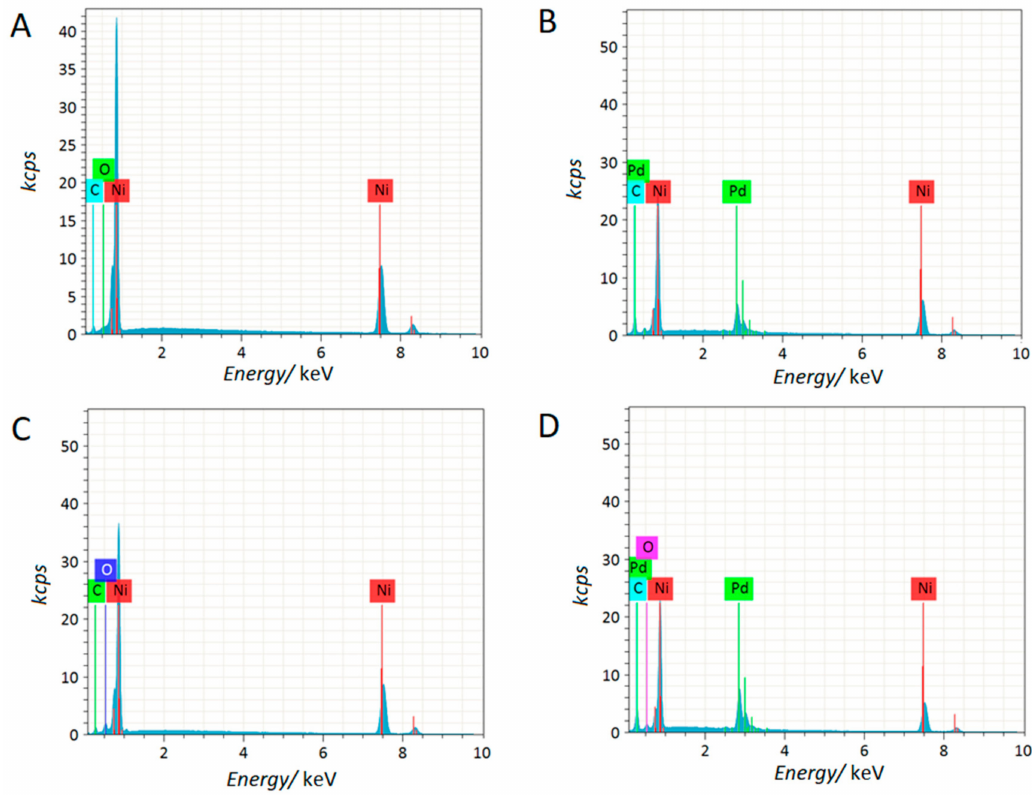
Figure 1. ( A ) EDX spectrum carried out at an acceleration voltage of 12 kV and the working distance of 9.8 mm for fresh Ni foam electrode; ( B ) as in ( A ), but for Pd-modified Ni foam; ( C , D ) as in ( A , B ) respectively, but after electrochemical